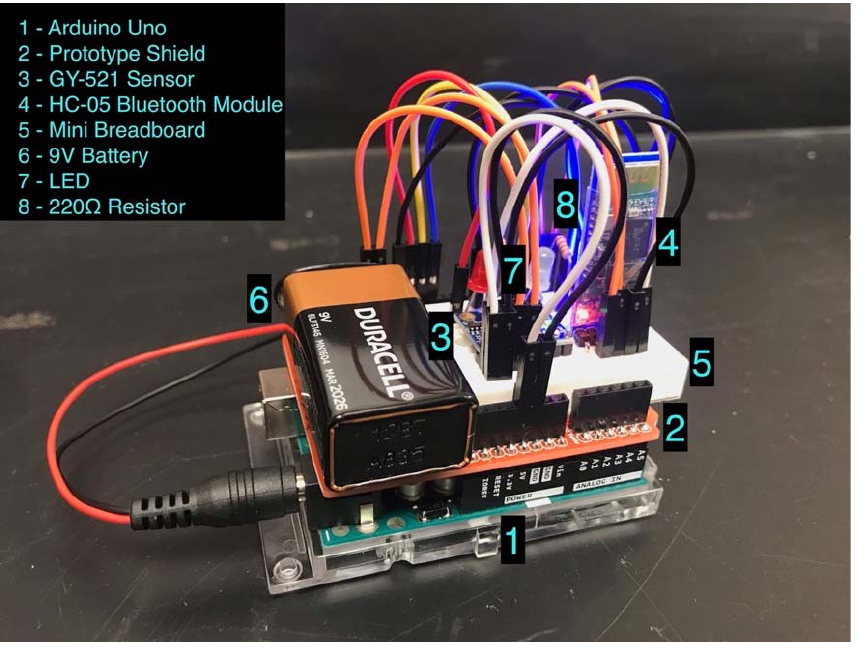
Figure 1. Designed Hardware System.